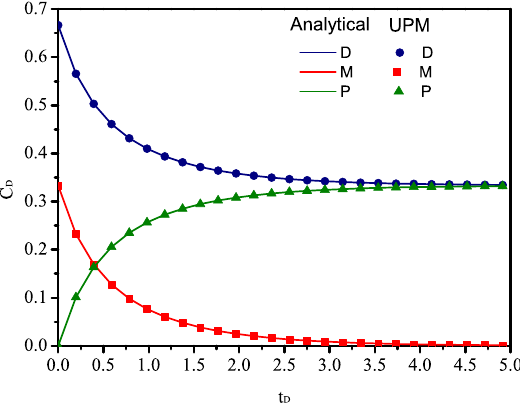
Figure 1. The variations of dimensionless concentration C D of reactant and product with dimensionless time t D